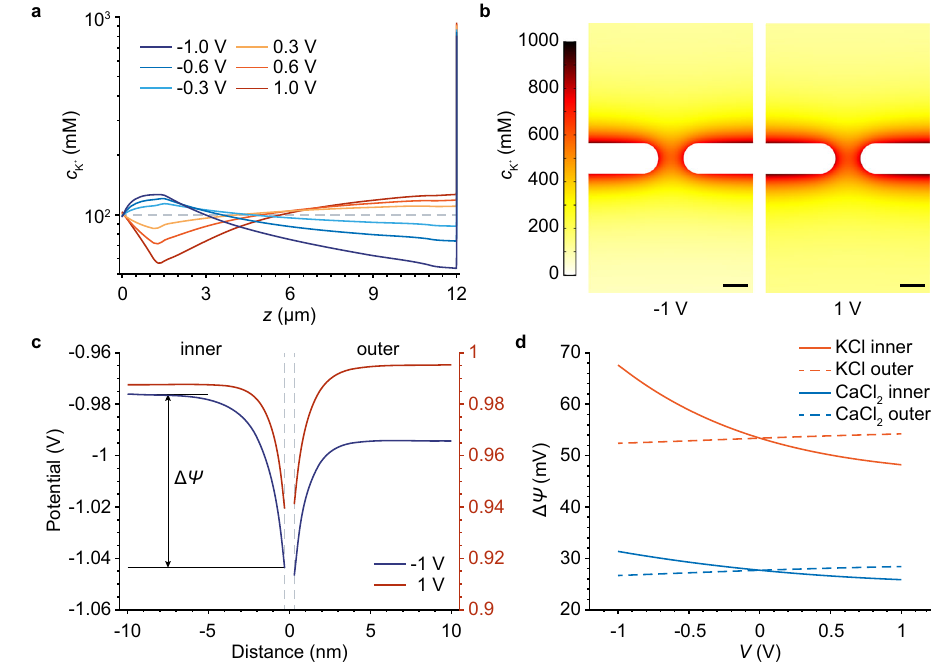
Fig. 4 | Numerical calculations of distributions of ion concentration and elec- tric potential in graphene-based polyethylene terephthalate nanochannel (GPETNC). a Concentration of potassium ion c K + along the center symmetryaxis z oftheGPETNCin0.1MKClsolutionatdifferentvoltages. z =0and12 μ mrepresent the tip and base side of the GPETNC, respectively. b Distributions of c K + nearby a graphenesubnanoporeoftheGPETNCin0.1MKClsolutionat − 1and1V.Scalebars are 0.5 nm. c Electric potential ψ at different distances away from the graphene